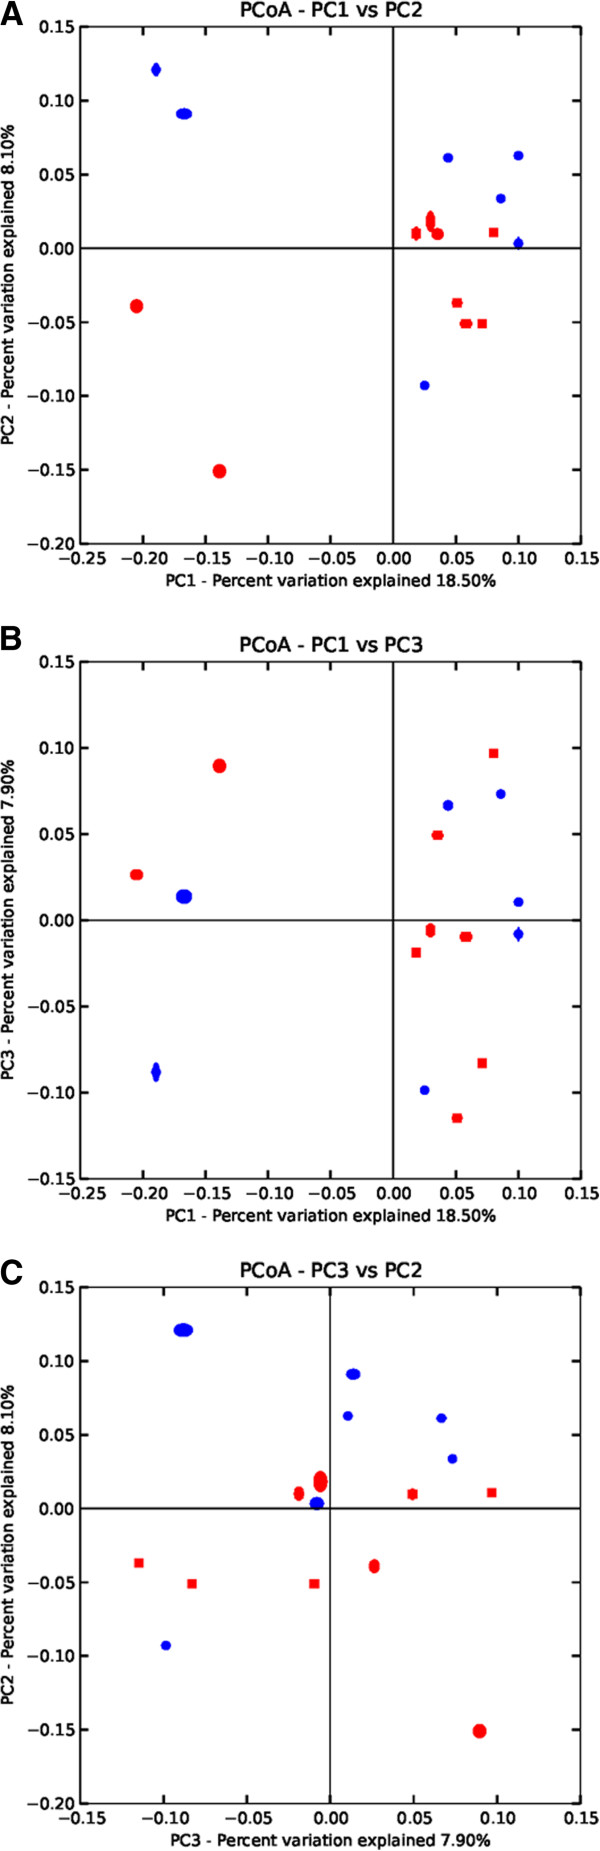
Principal coordinate analysis of unweighted UniFrac distances. Principal coordinate analysis (PCoA) plots were made using jackknifed UniFrac distances in QIIME. Red data points represent control horses and the blue horses with chronic laminitis. (A) PC1 versus PC2, (B) PC1 versus PC3, (C) PC2 versus PC3.